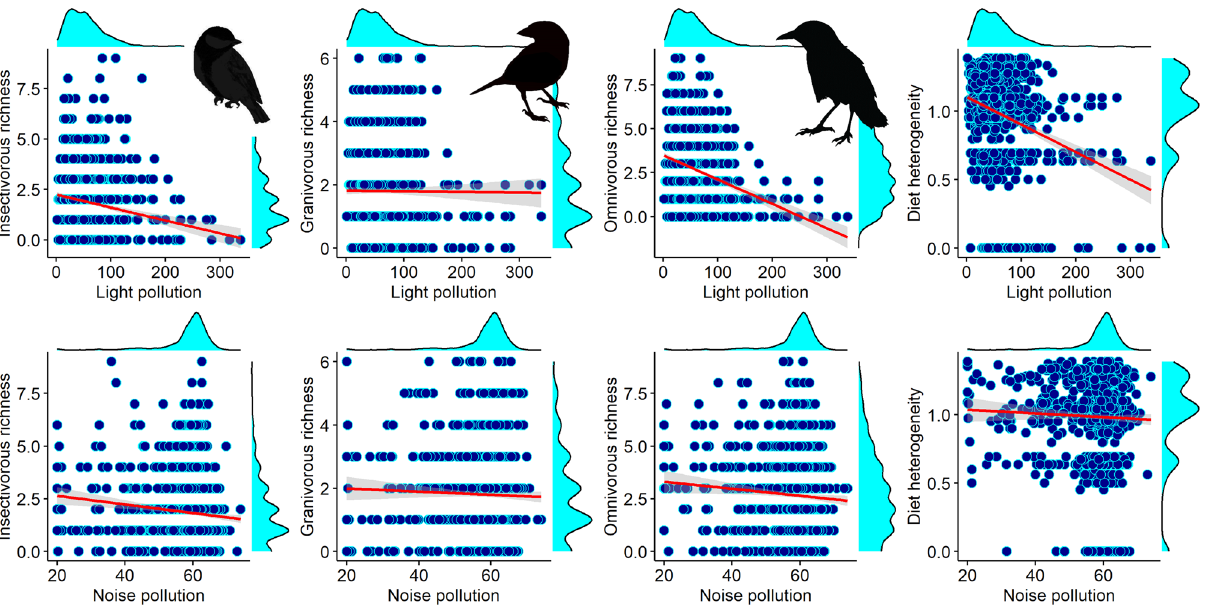
Figure 1. Association between light pollution (above) and noise pollution (below) with the number of granivorous, insectivorous and omnivorous species, plus the diet heterogeneity within the avian communities in fourteen European cities. The margins of each plot show the distribution density of the